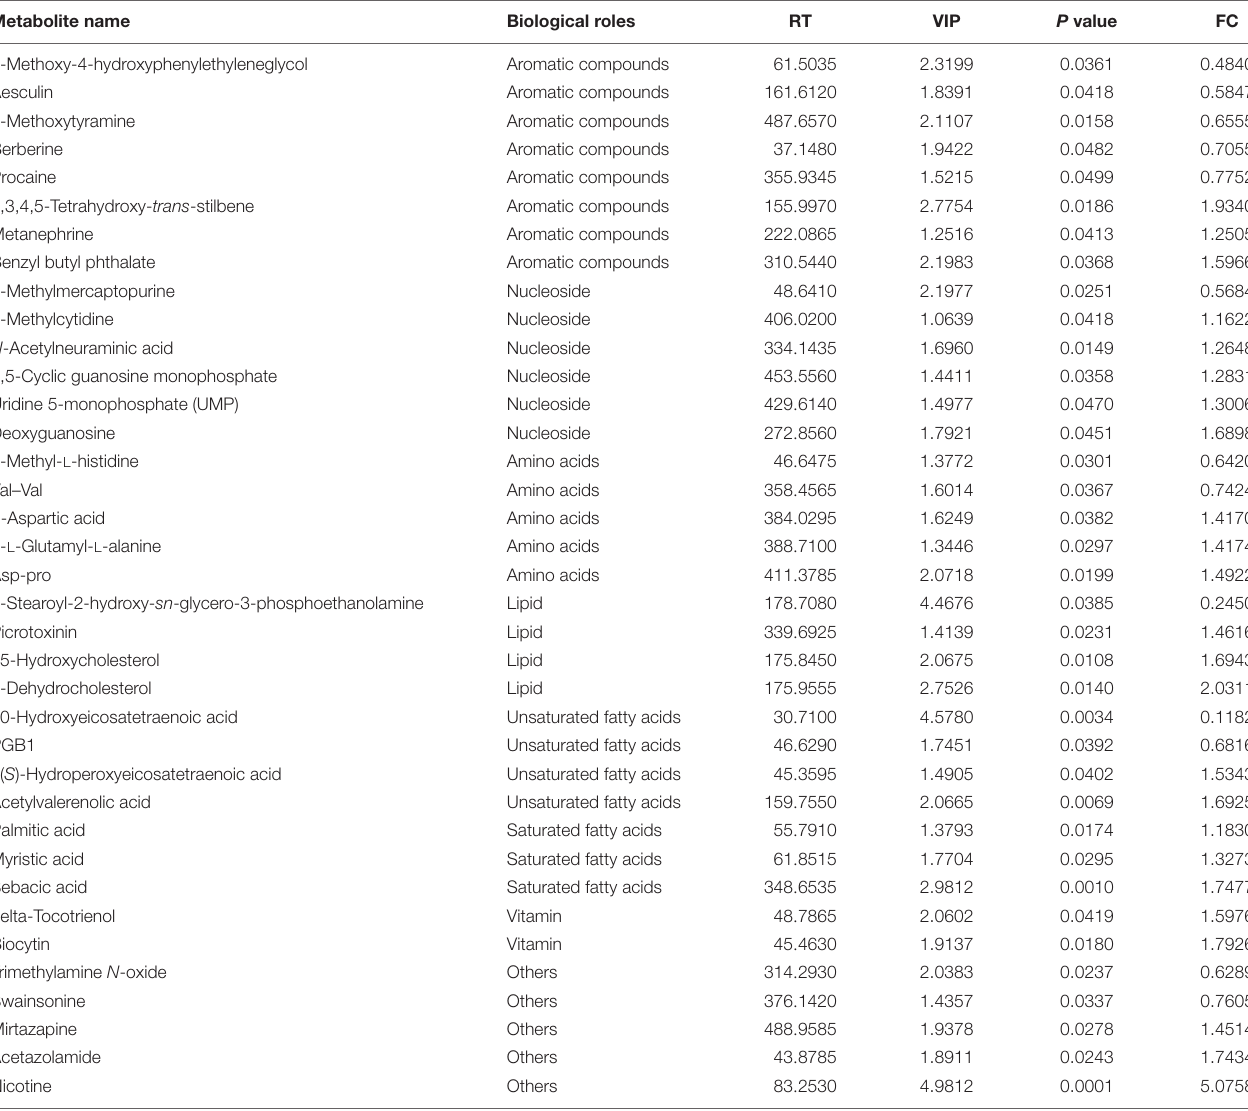
TABLE 3 | Identification of significant differential metabolites between the HIS group and control